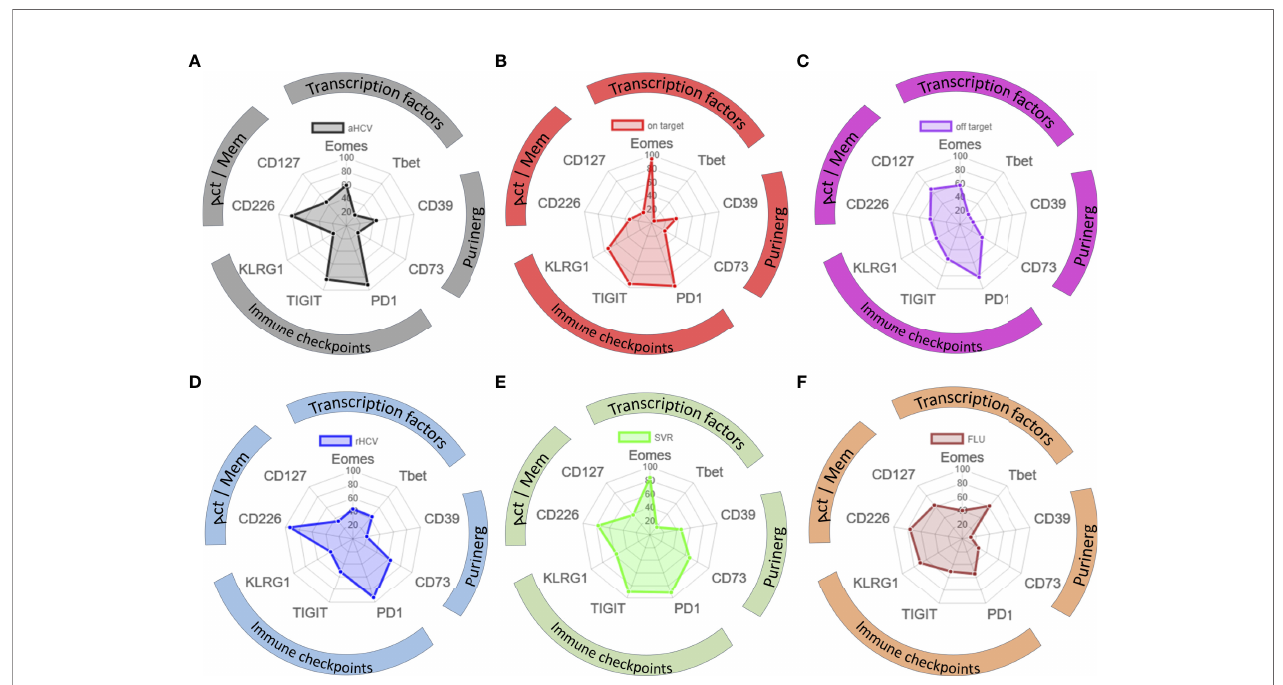
FIGURE 5 | (A – F) Phenotypic pattern of TOX+ HCV-speci fi c and TOX+ FLU-speci fi c CD8+ T cells. (A – F) Phenotypic pattern of HCV-speci fi c and FLU-speci fi c CD8+ T cells in radar plots: Act, activation; Mem, memory; aHCV, acute HCV; on target = chronic HCV with on-target T cells, off target = chronic HCV with off-target T cells, rHCV, spontaneously resolved HCV; SVR, successfully treated patients with a sustained virologic response; FLU, in fl uenza.